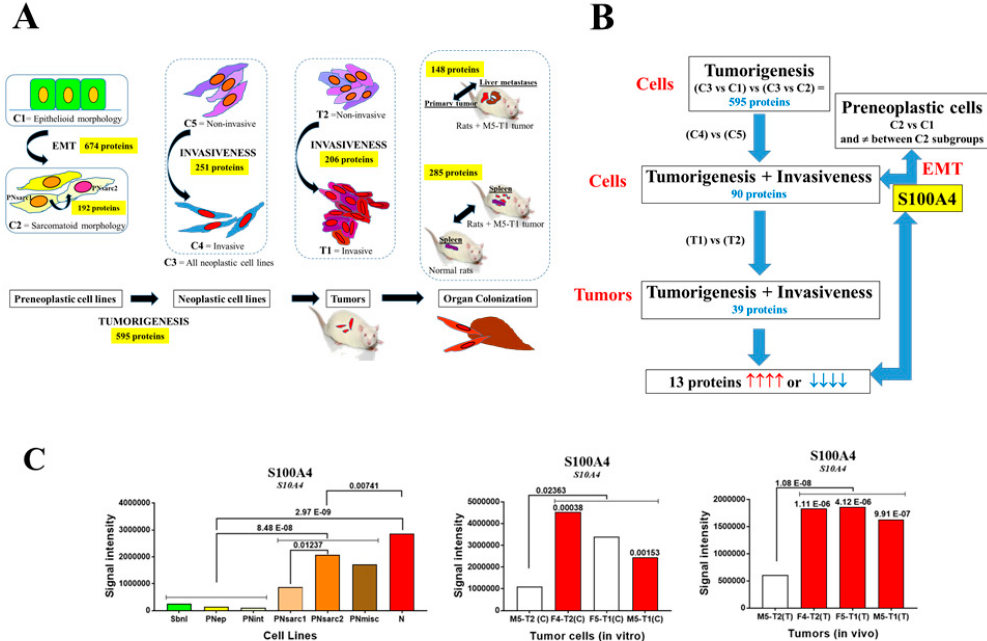
Figure 1. Identification of S100A4 as the main biomarker. (A) Scheme of the successive steps and sources of data used for the identification of candidate biomarkers. C1, preneoplastic cell lines with epithelioid morphology. C2, preneoplastic cell lines with sarcomatoid morphology. C3, neoplastic cell lines. C4, invasive neoplastic cell lines. C5, non-invasive neoplastic cell line. T1, invasive MM (malignant mesothelioma) tumors. T2, non-invasive MM tumor. (B) Methodology used for SWATH-MS (sequential window acquisition of all theoretical fragmentation spectra) proteomic analyses of cell lines and tumors. (C) Comparative proteomic abundances of S100A4 (significant increases in red and decreases in blue, with p values). Left: comparison between the different subgroups and groups of preneoplastic and neoplastic cell lines (in vitro); middle: comparison between invasive and non-invasive neoplastic cell lines (in vitro); right: comparison between invasive and non-invasive mesotheliomas (in vivo). Blank bars correspond to the absence of significant differences between cell lines/tumors.